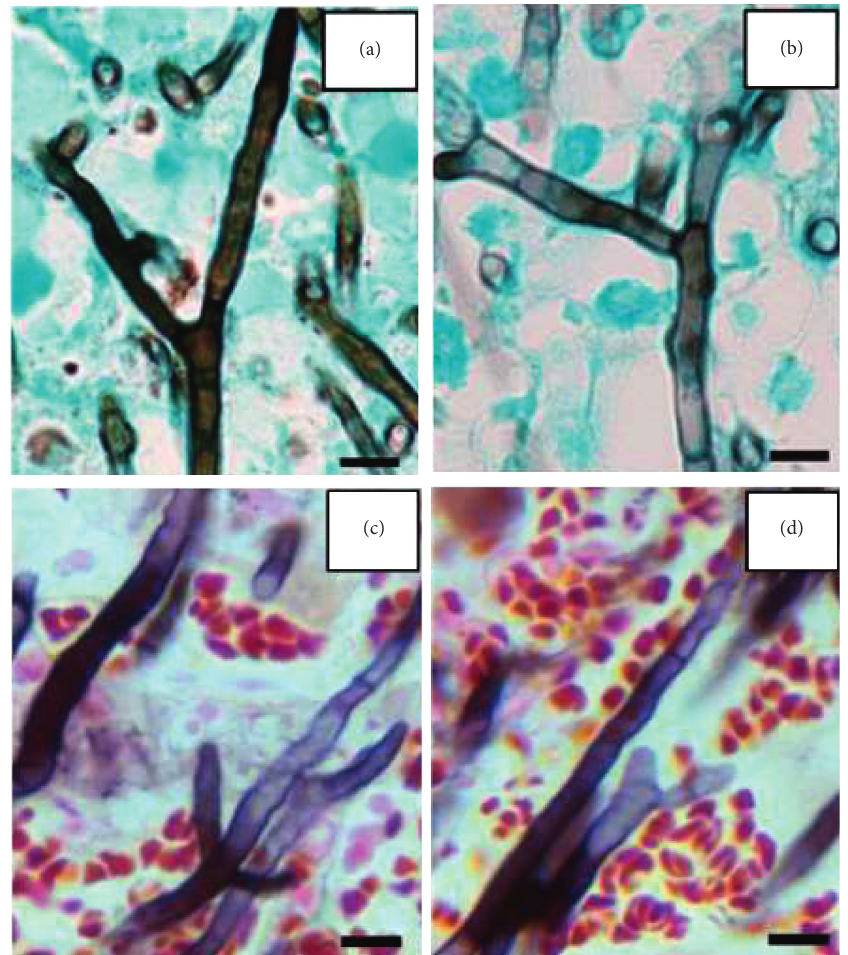
Figure 5: Comparison of fungal elements between two agents, both present with acute-degree branching hyphae. (a, b) Case report patient: Scedosporium boydii shows fork-shaped 45-degree branching hyphae. (c, d) Example Aspergillus patient: fungal hyphae demonstrating 45- degree alternating side branching in a biopsy specimen. Bar � 5 μ